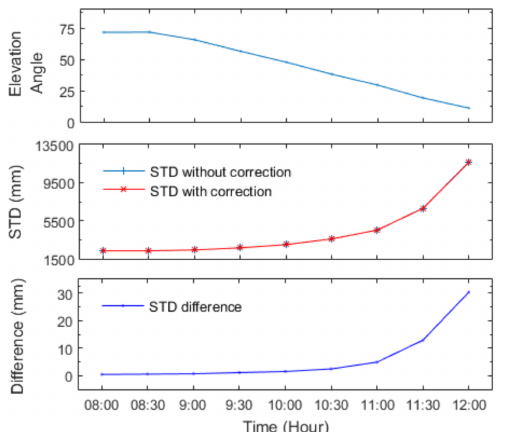
Figure 10. Elevation angle ( top ), time series of slant tropospheric delay (STD) ( middle ) and STD di ff erences ( bottom ) estimated from PRN 7 GPS satellite on day 167 in 2011 at ANRK